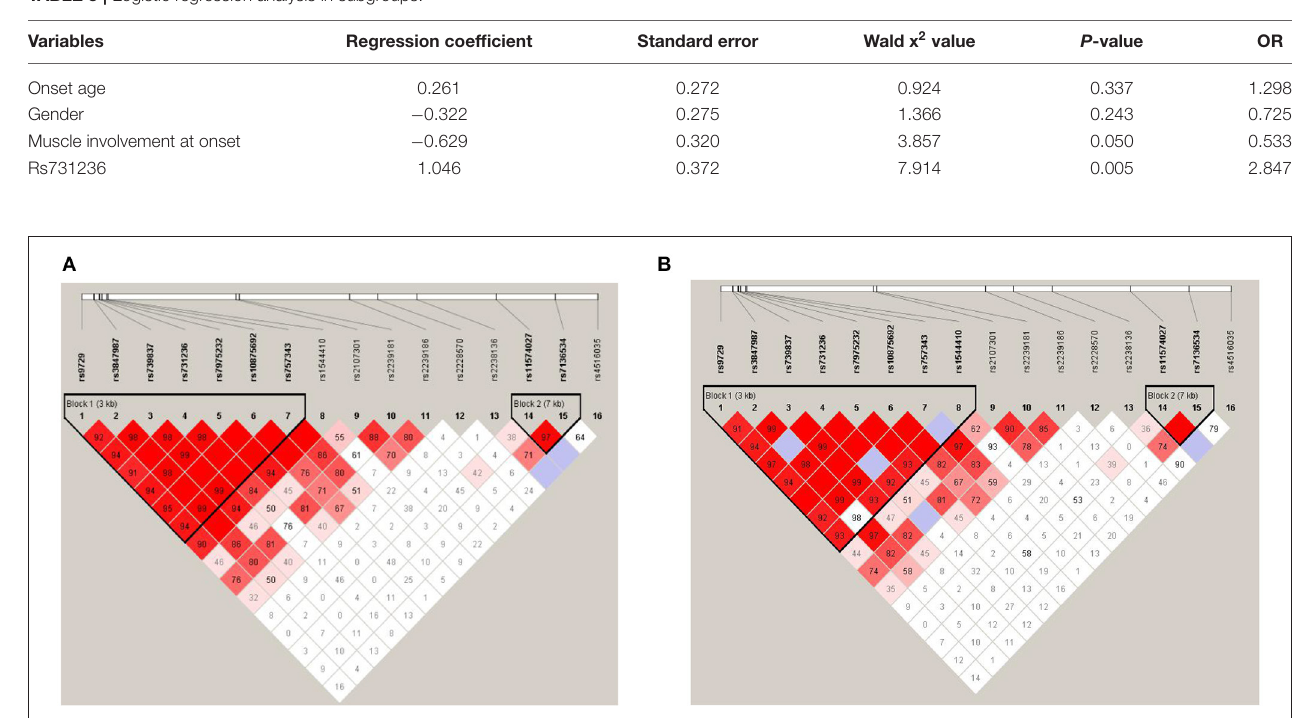
TABLE 3 | Logistic regression analysis in subgroups.